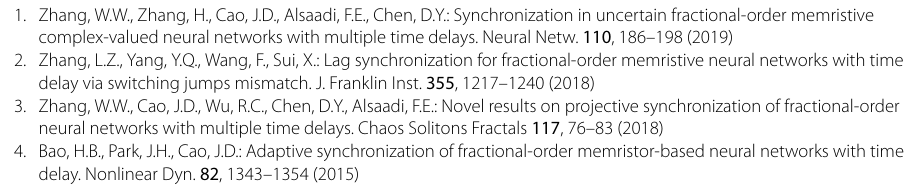
method. The synchronization of delayed QVMNN with parameter uncertainties warrants further